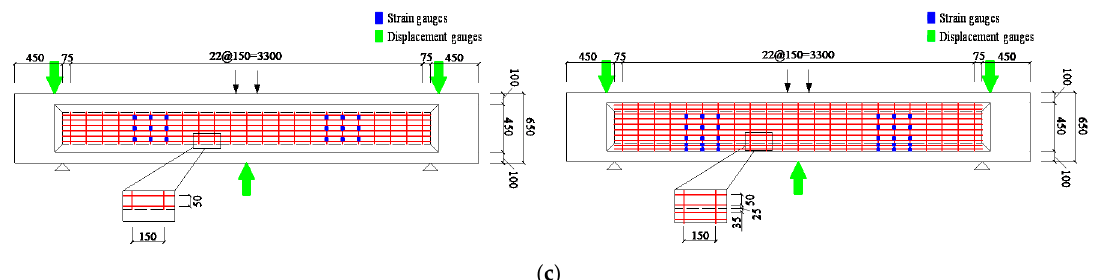
Figure 5. Schematic of specimens in Series A (Unit: mm): ( a ) Side view for strengthened beams (left side for RWC5, right side for RHWC5); ( b ) Front view for the reinforcement cage and the longitudinal section of the beam; ( c ) Front view for FRP grid area (left side for RWC5, right side for RHWC5).